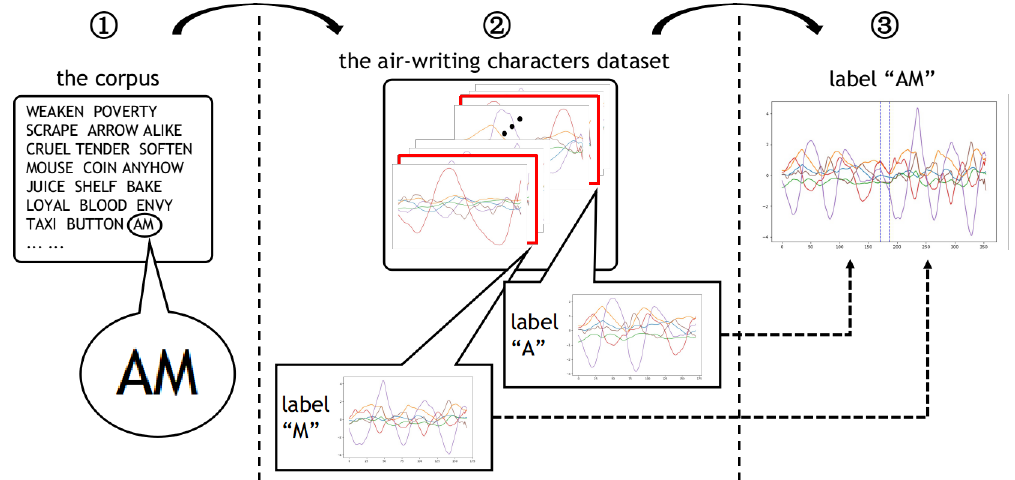
Figure 3. Pipeline of the splicing module. 1. The word “AM” is selected from the corpus. 2. A character sample labeled “A” and a character sample labeled “M” are picked from the air-writing character dataset. 3. The two character samples mentioned above are stitched together, but a gap is left between them. Then, the gap is filled using linear